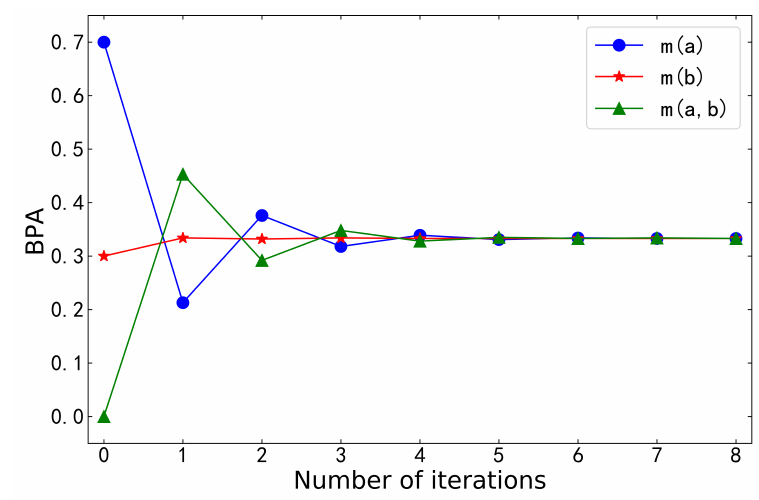
Figure 2. BPA after logarithmic negation iterations in Example